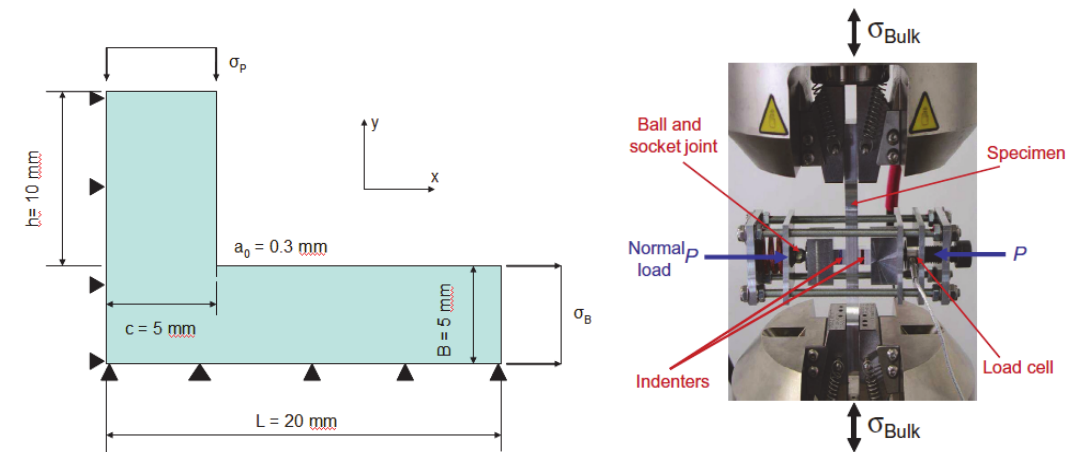
Figure 5: Left, model geometry. Right, complete contact testing rig, showing the contact elements.